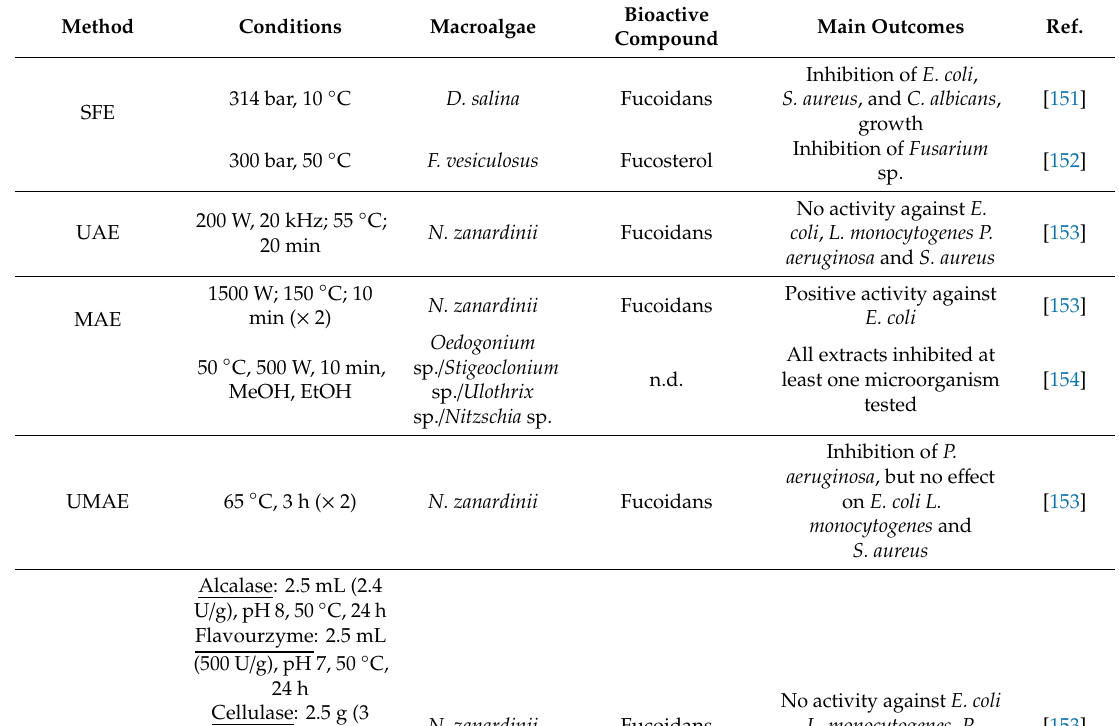
Table 3. Antimicrobial activity of macroalgae crude extracts obtained using emerging extraction